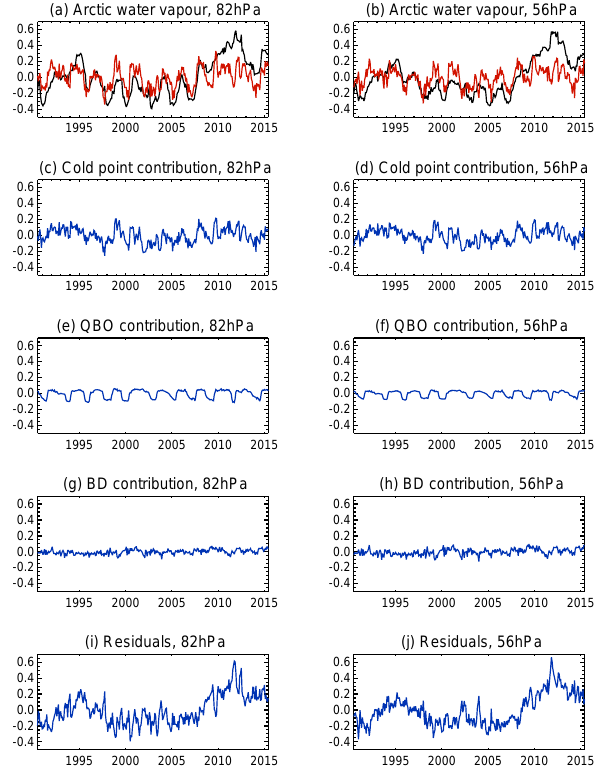
Figure 6. The contribution of individual processes to water vapour